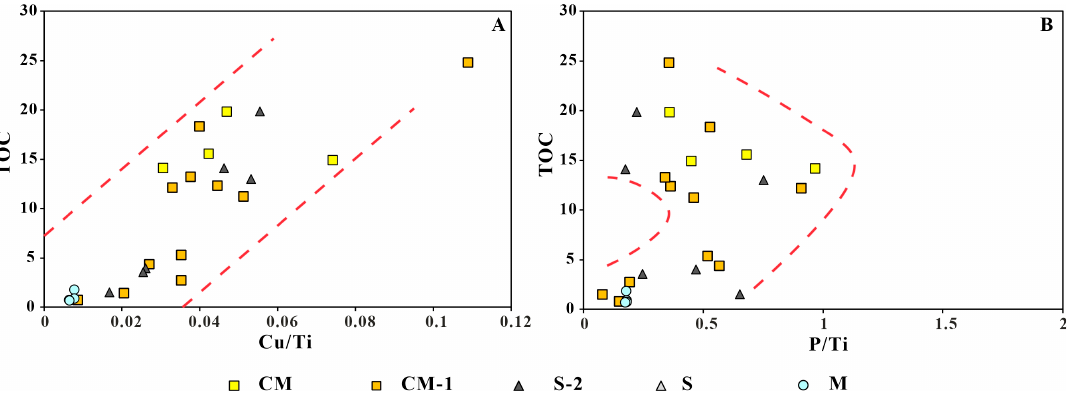
Figure 9. ( A ) Crossplots of Cu/Ti versus TOC contents. ( B ) Crossplots of P/Ti versus TOC contents for paleo-productivity of the Chang 7 Member in the Ordos Basin .